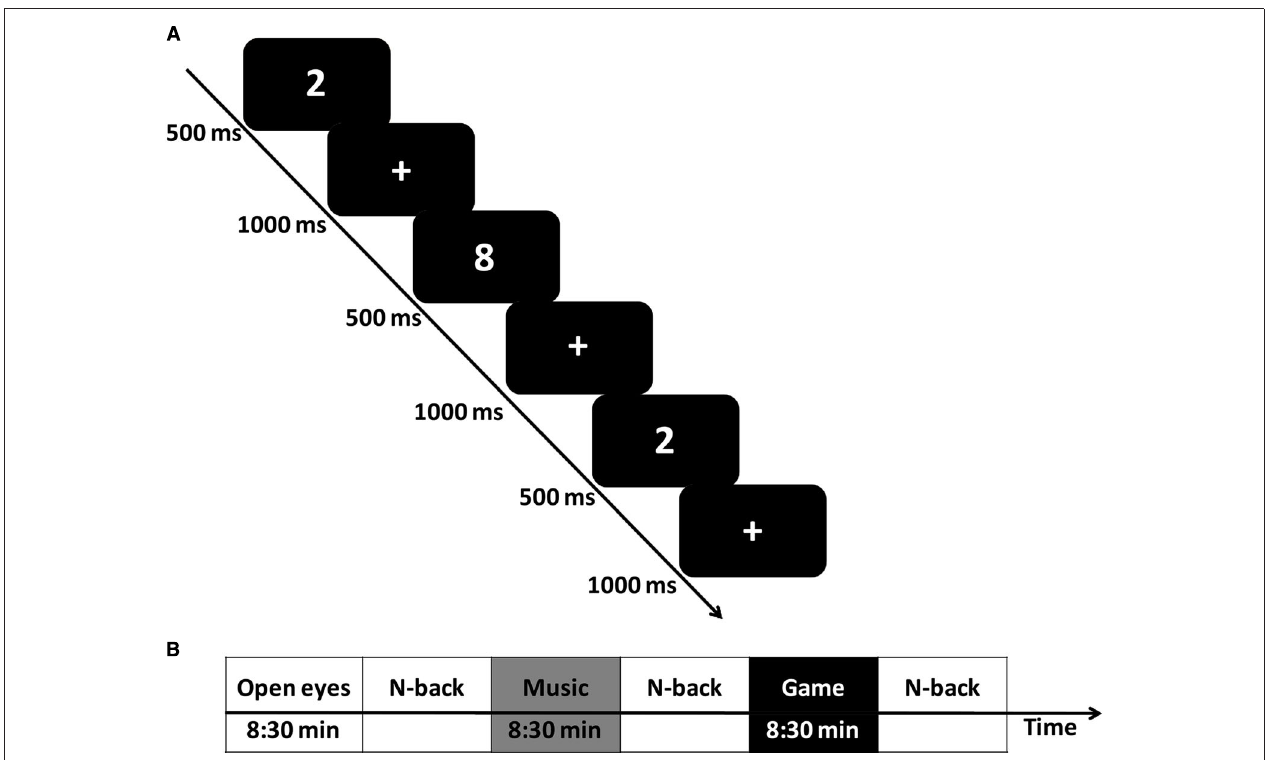
FIGURE 1 | (A) N -back task (example: 2-back). White numbers were presented on a black background for 500 ms each, followed by a white fixation cross. The length of the interstimulus interval (ISI) was 1000 ms. (B) Testing